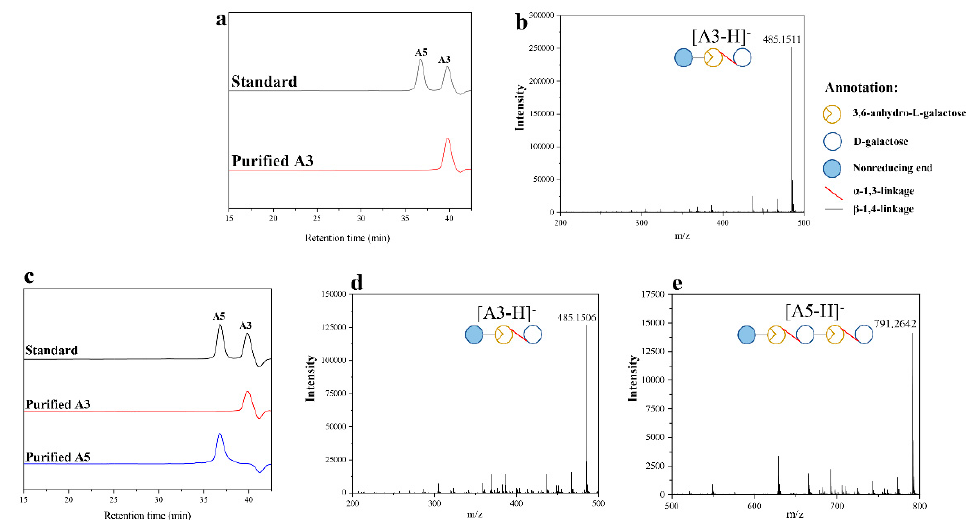
Figure 6. HPLC analysis of the obtained pure A3 produced by AgWH50B ( a ) and pure A3, A5 produced by DagA ( c ). ESI-MS analysis of the results of pure A3 produced by AgWH50B ( b ) and pure A3, A5 produced by DagA ( d , e ).